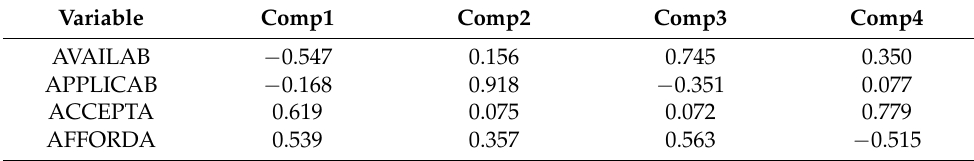
Table A2. Principal components